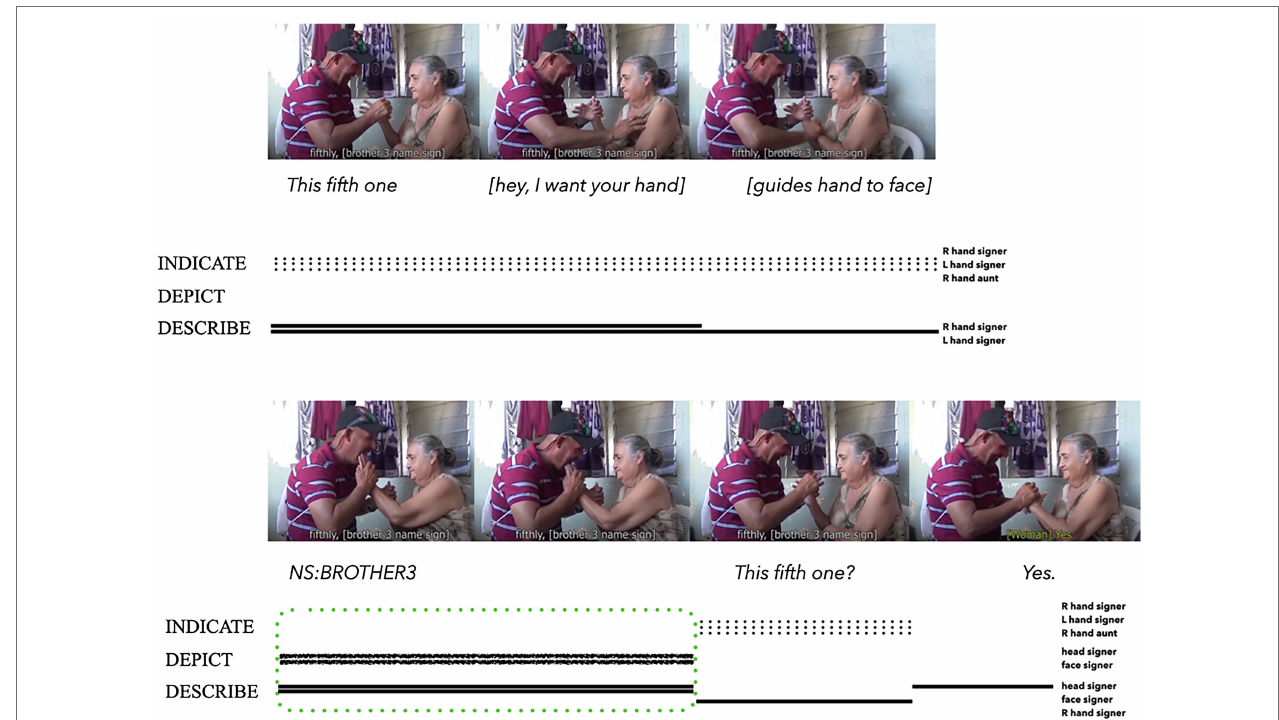
FIGURE 9 | Composite utterance produced by a deafblind BISL signer (adapted from Ali, 2020: 07:18–07:24 and reproduced with permission from the